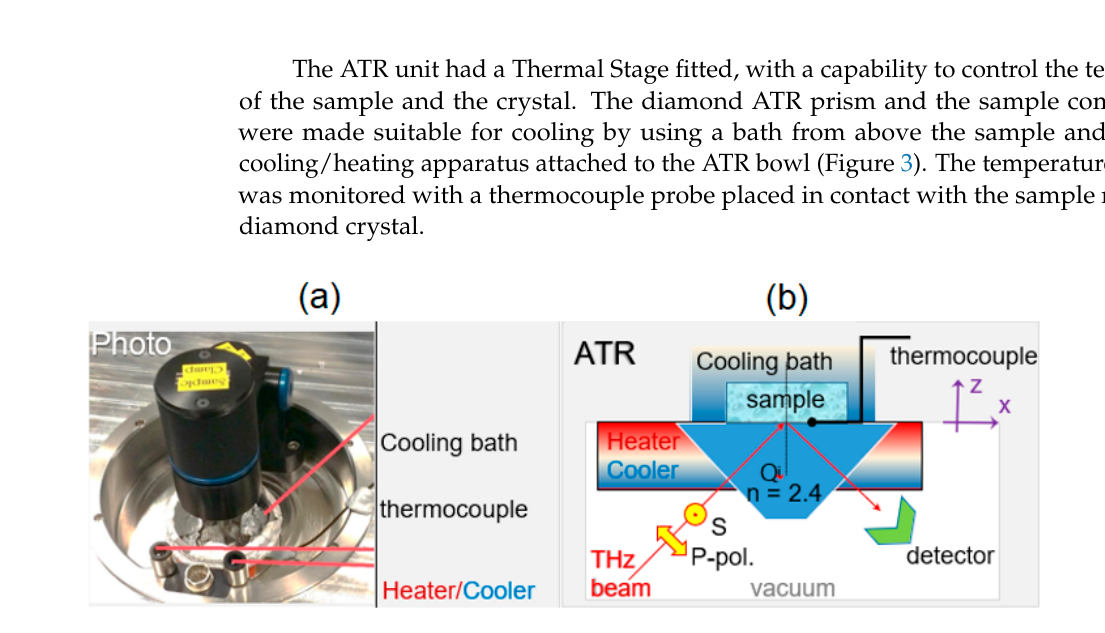
Figure 3. ( a ) Photo and ( b ) schematics of ATR setup with Thermal Stage used for temperature dependent absorbance spectroscopy at the THz/Far ‐ IR beamline with Thermal Sample Stage attached.